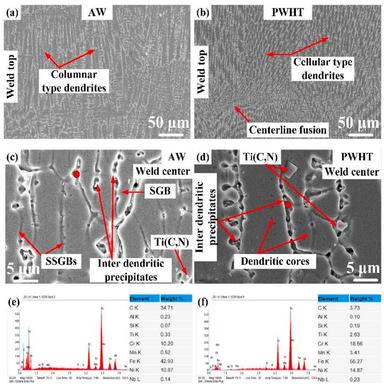
FE-SEM micrograph and EDS spectrum of (a) WFZ in AW state; (b) WFZ in PWHT state; (c) dendrites in AW state WFZ; (d) dendrites in PWHT state WFZ; (e) elemental composition of spotted interdendritic particles in AW states WFZ; (f) elemental composition of spotted interdendritic particles in PWHT states WFZ.